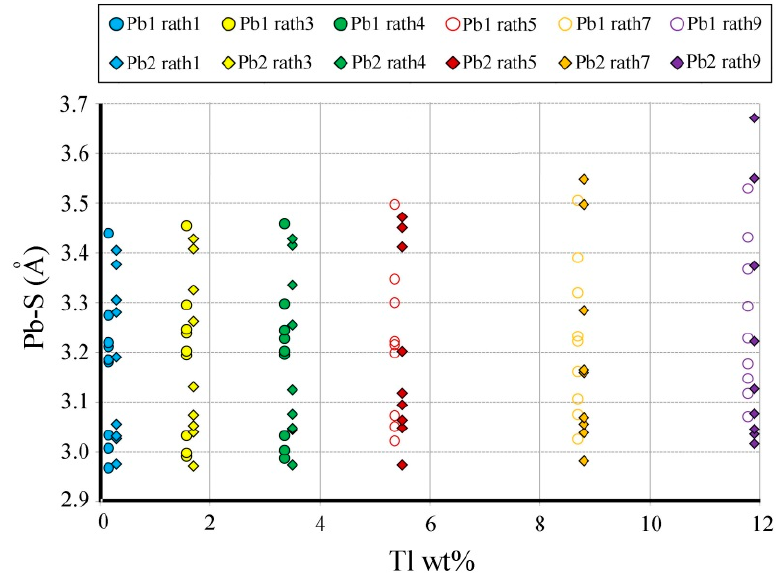
Figure 8. Pb–S bond-length variation for Pb1 (circles) and Pb2 (diamonds) sites in the structurally investigated rathite samples as a function of their thallium substitution.